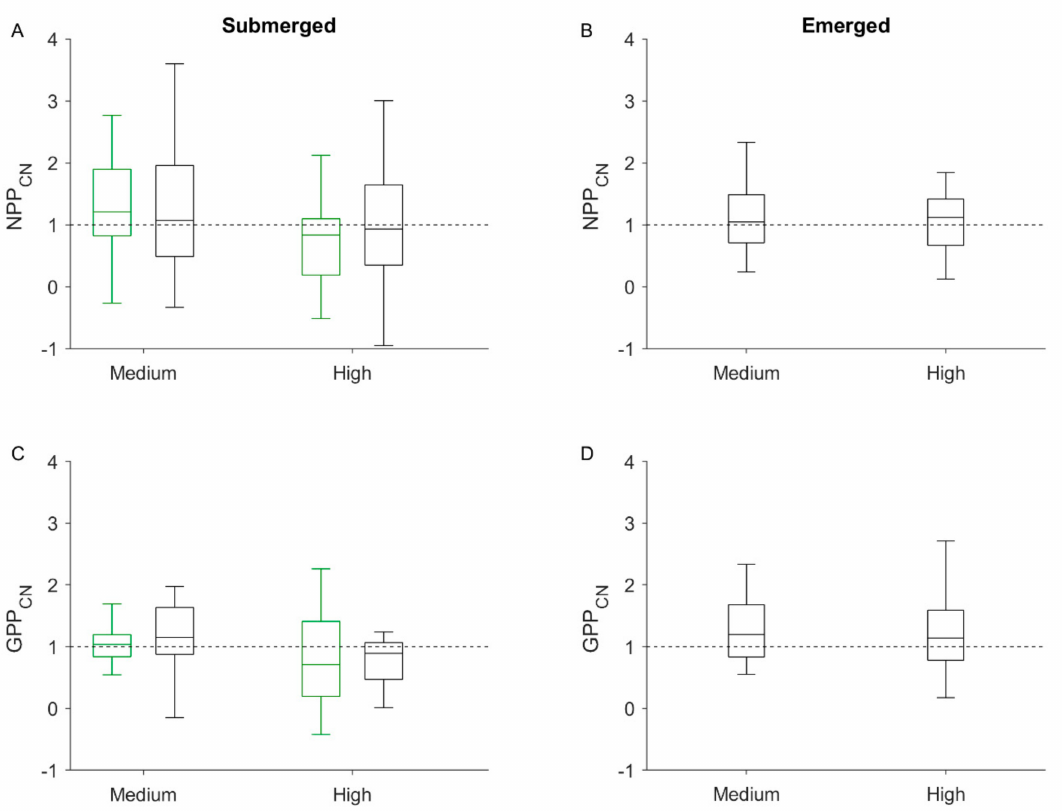
Figure 3. E ff ect of nutrient enrichment on control normalised net primary production (NPP) ( A , B ) and gross primary production (GPP) ( C , D ) during submerged and emerged tidal periods, respectively. Data are pooled across sites and green boxes represent data from T1 (November 2017 where no emerged data were collected) and black boxes from T3 (November 2018). Boxes are the 25th and 75th percentiles, and whiskers the 5th and 95th percentiles. The dotted line is provided as a reference to control